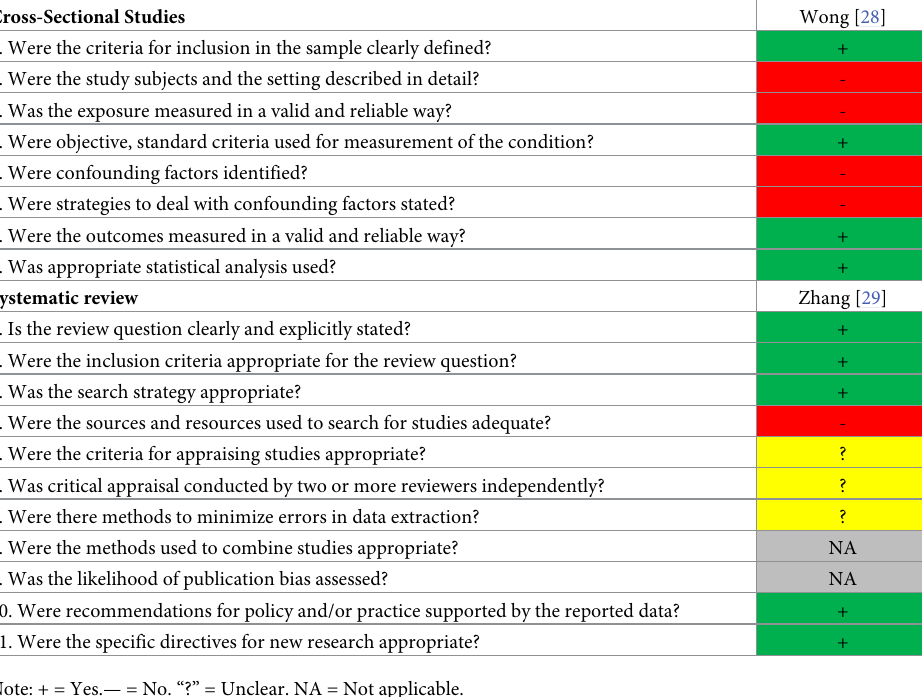
Table 2. Checklist of Joanna Briggs Institute (cross-sectional and systematic review). Cross-Sectional